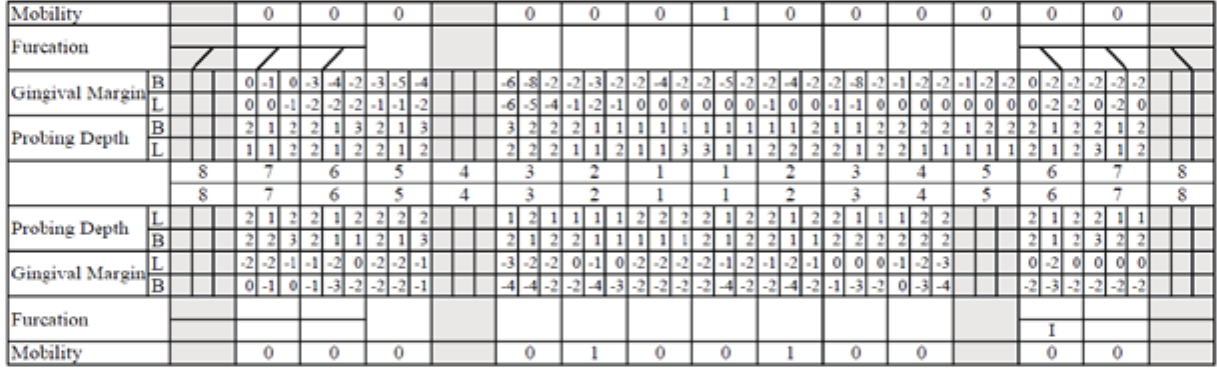
Figure 9. Post-treatment periodontal